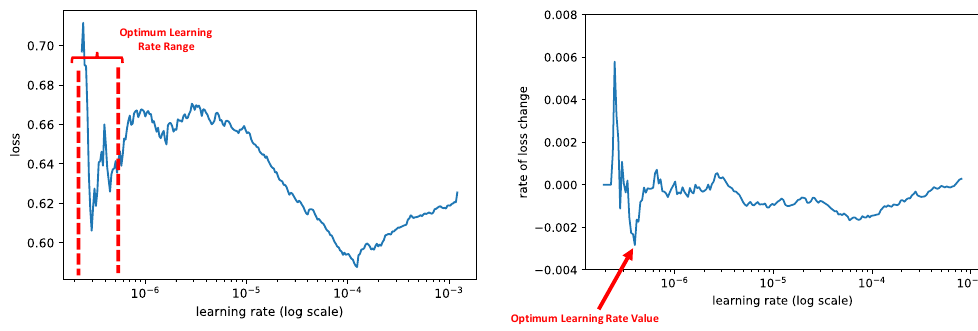
Figure 5. Impact of learning rates when fine-tuning our